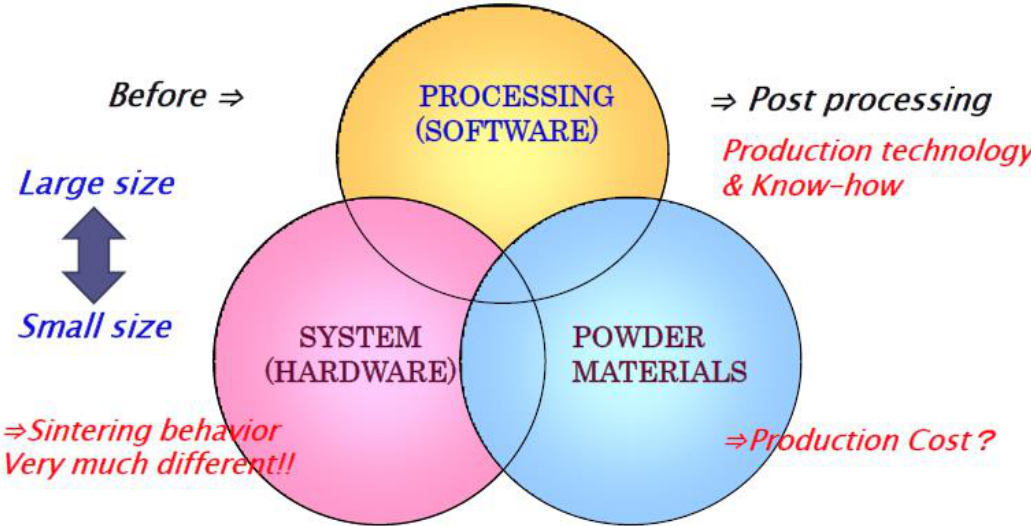
Figure 49. Trinity concept for SPS industrialization.